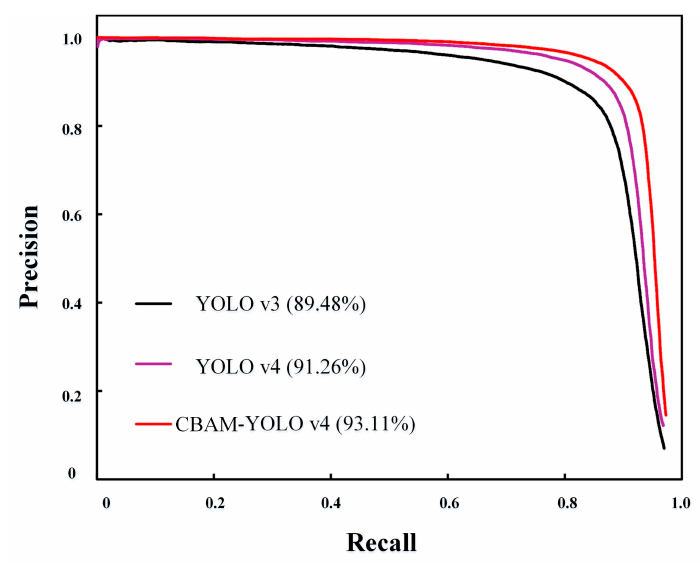
Figure 12. Precision–recall curves of the detection results of different algorithms with test set.